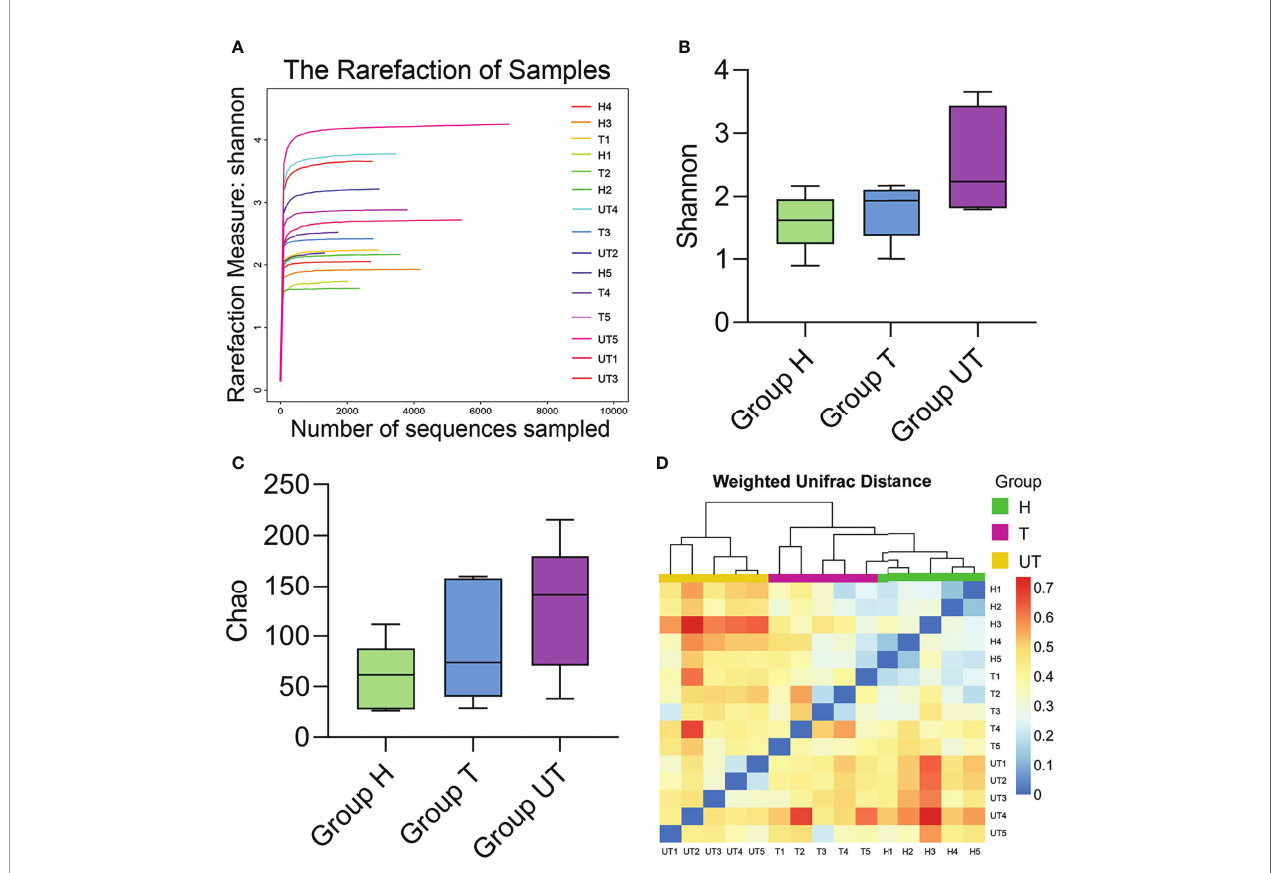
FIGURE 2 | Diversity analysis of microecological communities in the saliva samples of HIV-infected/AIDS patients after HAART. (A) Rarefaction curve of Shannon index in the fl ora of saliva samples in different groups. (B) Comparison of Shannon index in HAART processed or unprocessed HIV-infected/AIDS patients. (C) Comparison of Chao1 index in HAART processed or unprocessed HIV-infected/AIDS patients. (D) Heat map of b -diversity the fl ora of saliva samples in different